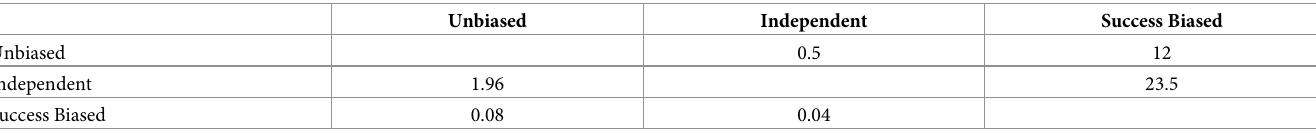
This table should be read row by row: the number in each cell reveals how much more likely the model in the corresponding row is to explain the data than the model in the corresponding